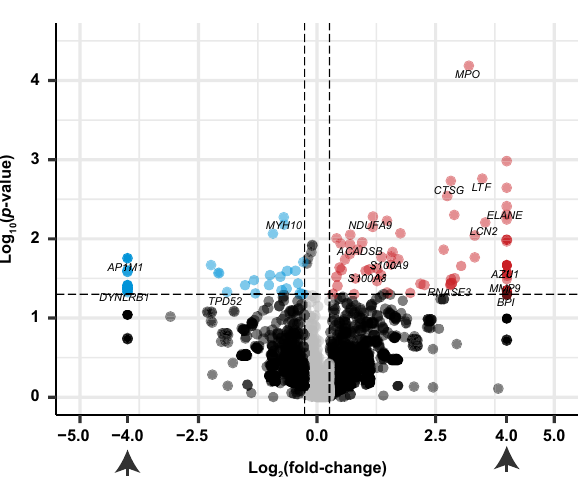
Figure 1. Volcano plot of the 3153 proteins identified by LC–MS/MS. The volcano plot shows the fold-change (x-axis) versus the significance (y-axis) of the identified 3153 proteins. The significance (non-adjusted p -value) and the fold-change are converted to −Log 10 ( p -value) and Log 2 (fold-change), respectively. The vertical and horizontal dotted lines show the cut-off of fold-change = ± 1.2, and of p -value = 0.05, respectively. Those proteins with N/A fold-change are plotted on Log 2 (fold-change) = ± 4 (arrows). There were 115 proteins increased by > 1.2-fold with p -value < 0.05 in AF (upper-right, dots colored red), and there were 55 proteins that were decreased by < − 1.2-fold with p -value < 0.05, (upper-left, dots colored blue). The volcano plot was generated using R software 54 (version